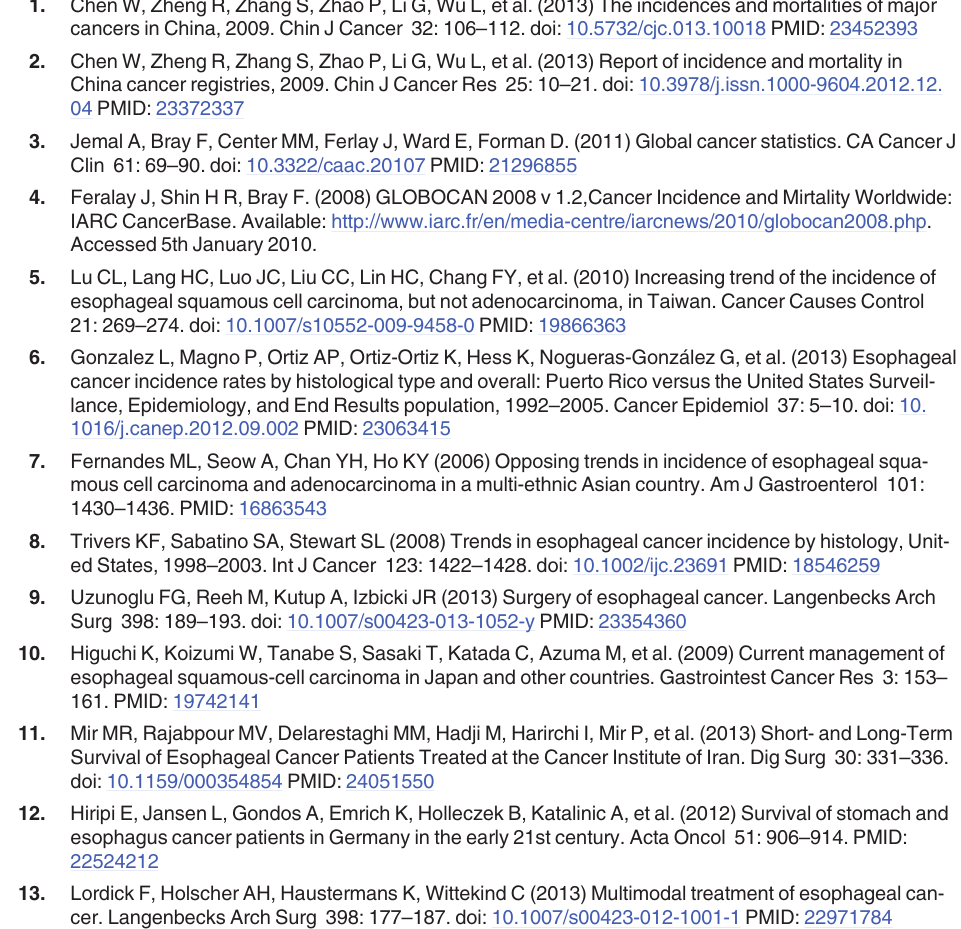
Fig 4. Distribution of the nomogram predicted 5-year survival according to (A) the sixth edition, and (B) the seventh edition of the TNM staging system. The predicted survival probabilities in each of the TNM stages exhibit a wide range of